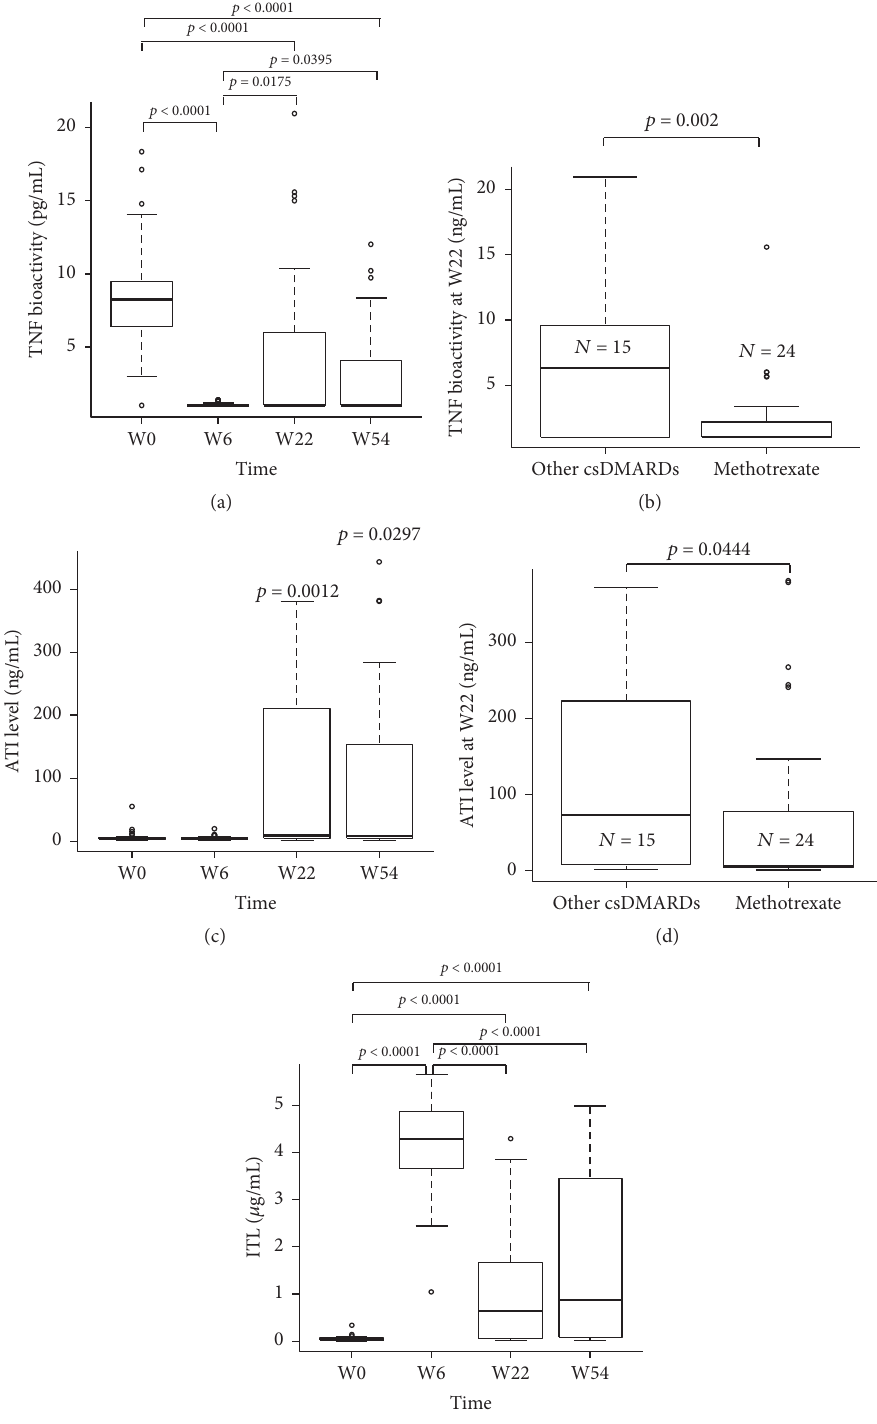
Figure 1: Evolution of TNF bioactivity, IFX trough concentration, ATI concentration during IFX treatment, distribution of TNF bioactivity according to EULAR response, and effect of methotrexate on ATI concentration and TNF bioactivity. TNF bioactivity (a) decreased strongly at W6 with a slight increase afterwards. TNF bioactivity was lower in patients with methotrexate compared to patients with other csDMARDs (b). ATI (c) were detected at W22 and W54 and ATI concentration was lower in patients with methotrexate compared to patients with another csDMARDs(e).IFXtroughconcentration(d)stronglyincreasedatW6andthenslightlydecreasedafterwards.Theboxplotsshowthemedian values and the first and third quartiles at each time. The T bars represent the rest of the data with a maximum of 1.5 times the interquartile range. Circles represent values lower or higher than 1.5 times the interquartile range. TNF: tumor necrosis factor; ATI: antibodies towards IFX; W: week; csDMARDs: conventional synthetic disease modifying antirheumatic